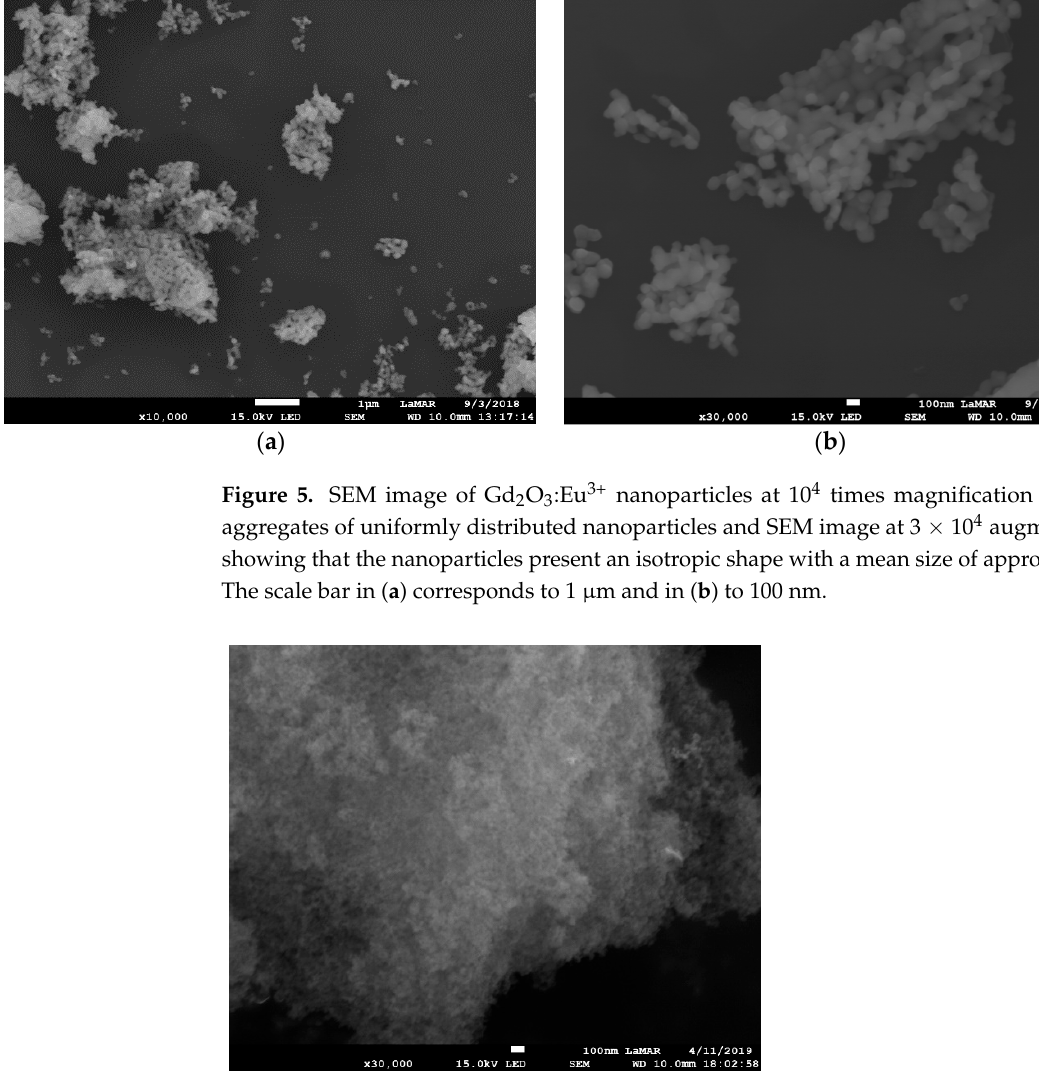
O and Si are the most visible elements. These elements are homogeneously distributed in the nanosilica matrix.